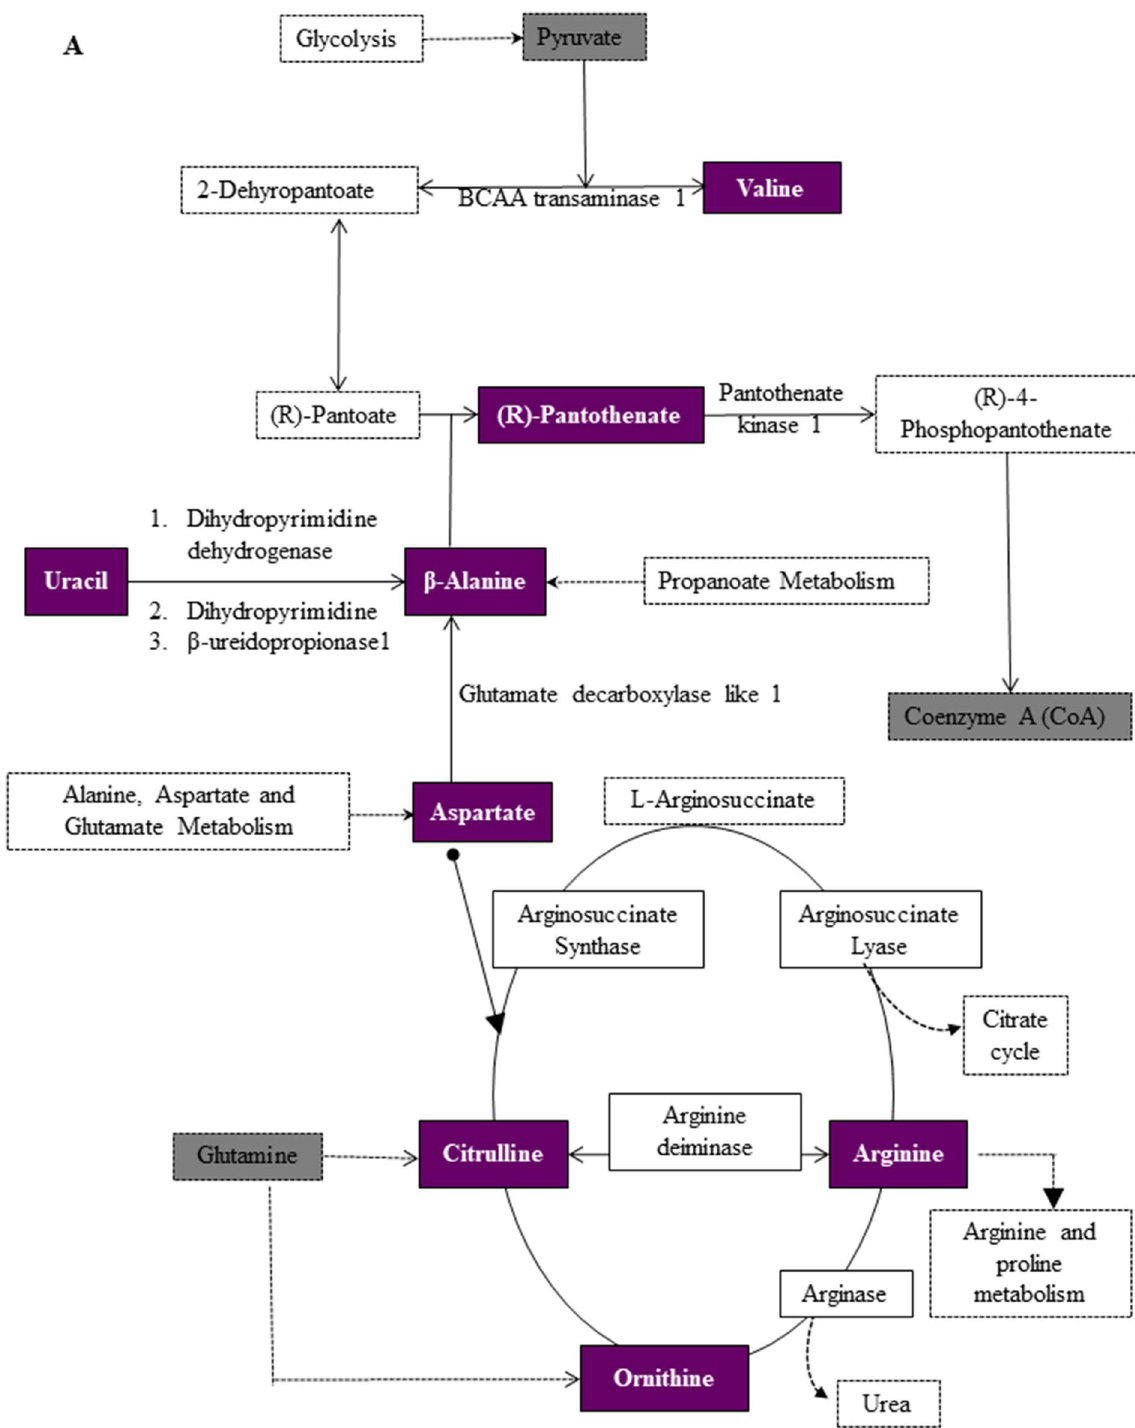
Figure 5. Representative metabolic pathway maps of significantly altered metabolites during proliferation and differentiation. Key metabolites related to ( A ) Pantothenate and CoA biosynthesis and Arginine and Proline metabolism that display significant alteration during proliferation and ( B ) Glutathione metabolism, ( C ) Tryptophan metabolism during differentiation. Colored boxes represent identified metabolites. Images were modified from map00770 and map00220 respectively for ( A ), map00480 for ( B ), and map00380 for ( C ) from the KEGG database (https